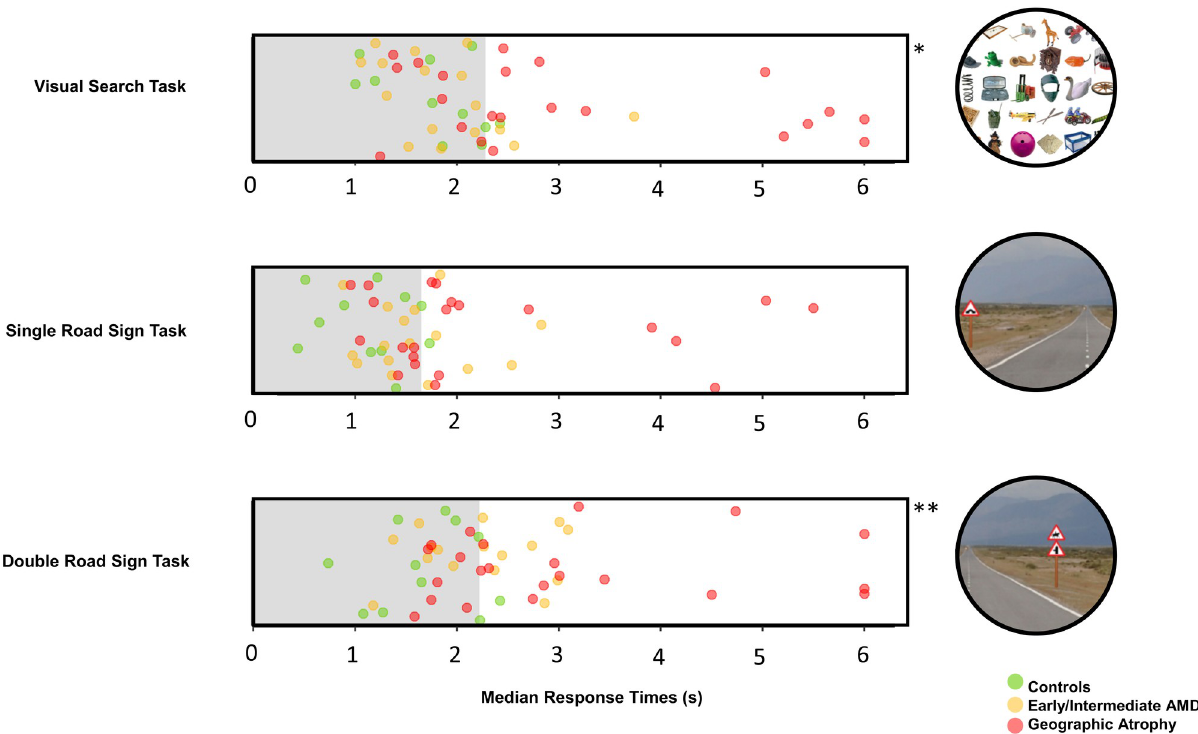
Fig 2. Plot of median response times. Median response times (seconds) capped at 6 seconds for the three participant cohorts with respect to the normative limit, shown as the shaded area. The normative limit for the visual search task was 2.28s, for the single road sign task was 1.65s and for the double road sign task was 2.22s. � The original RTs for two GA group participants whom were capped at 6 seconds were 8.5 and 11.4 seconds. �� The original RTs for three GA group participants whom were capped at 6 seconds were 7.4, 7.0 and 6.6 seconds.